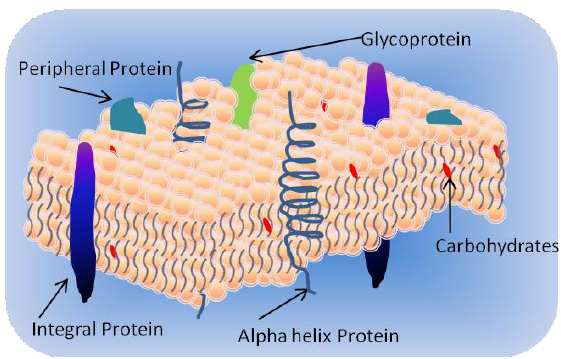
Figure 1. A lipid bilayer membrane